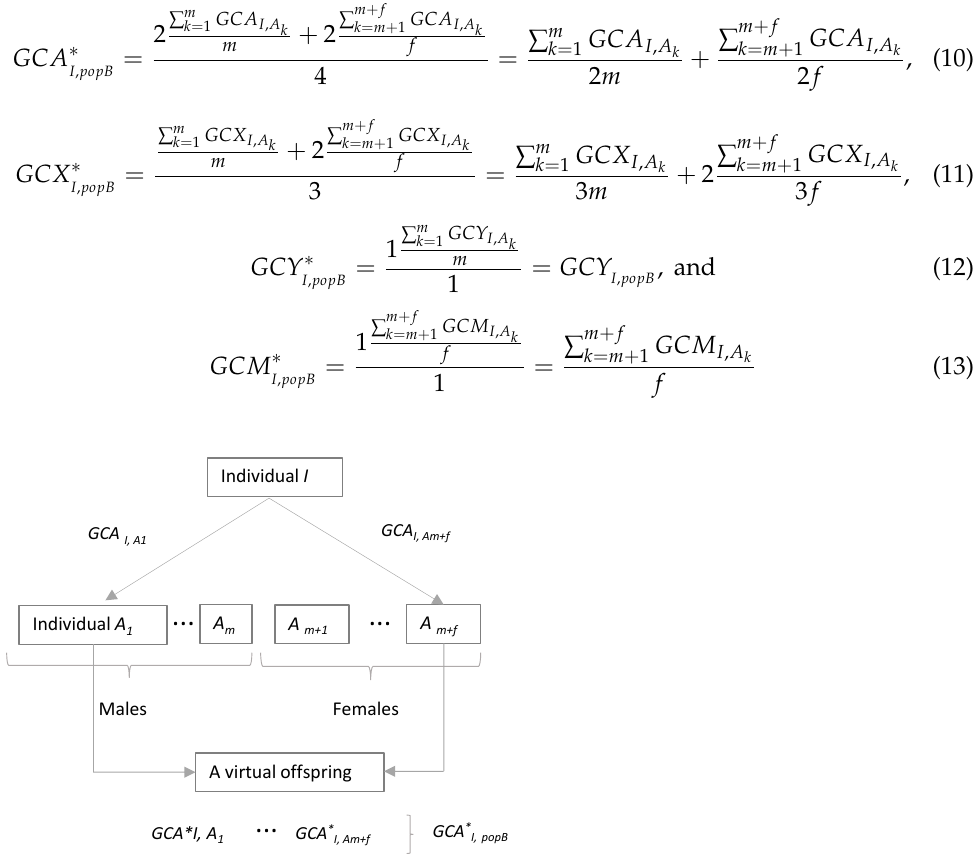
Figure 2. Concept of calculating weighted average of genetic contribution of individual I to a target population B , showing GCA * as an